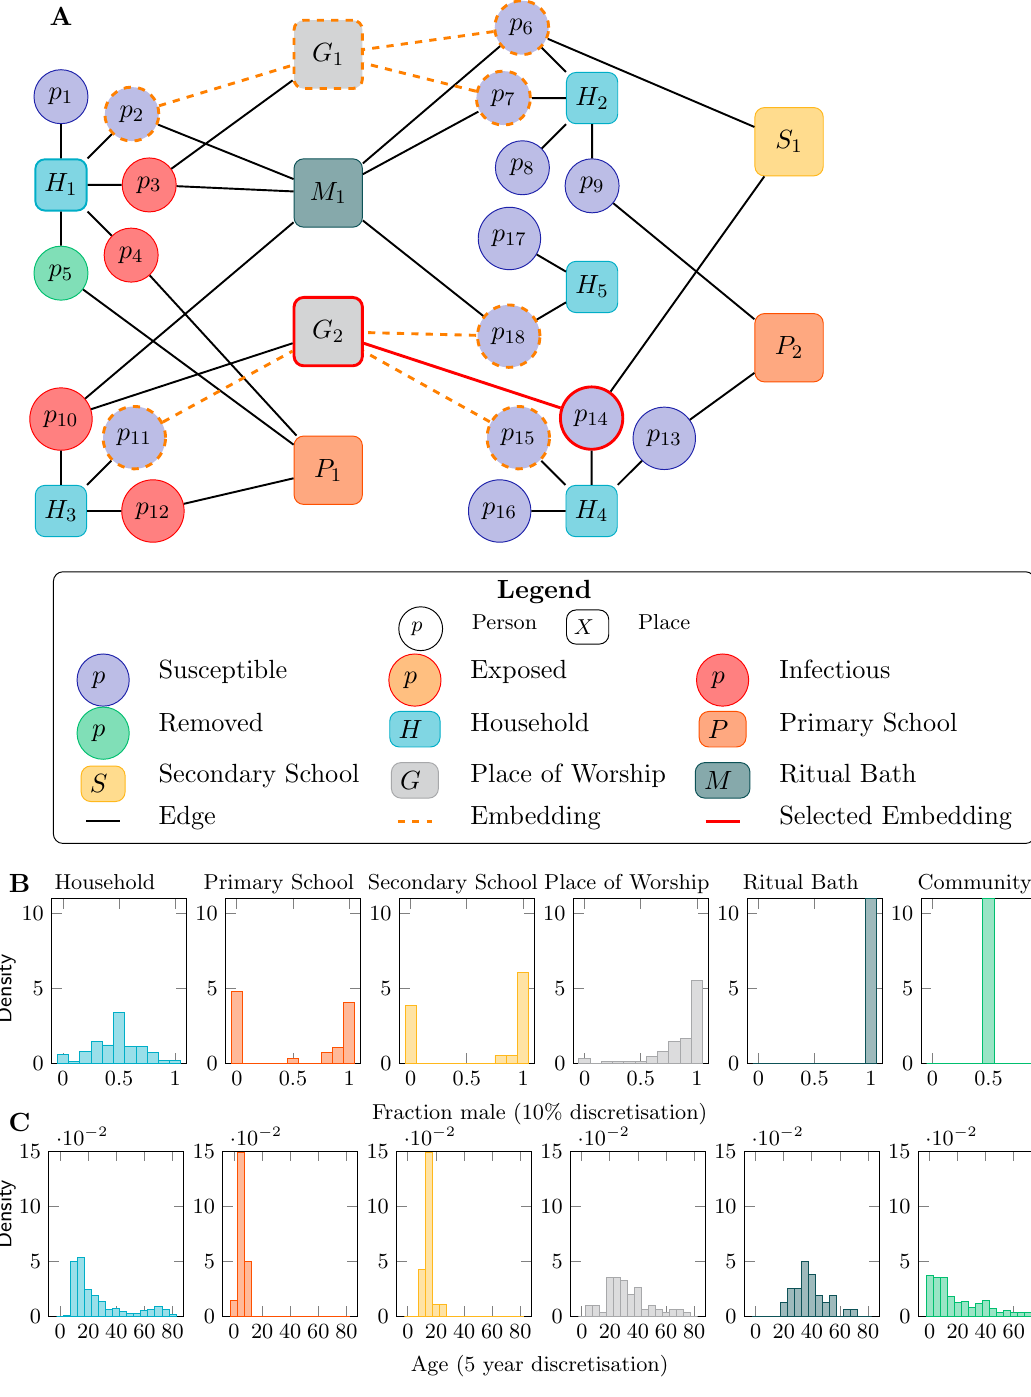
Figure 1. The data and formulation of the people and places network. ( A ) Illustrative representation of a bipartite people and places network. Circles represent people and squares represent places. All people are connected to a household (H). Some people are connected to primary (P) or secondary (S) schools, places of worship (G) or ritual baths (M). The orange dotted, and red solid edges represent embeddings of a transmission rule (Eq. 6) capturing the situation immediately before a transmission event that will result in the individual p14 becoming infected. ( B ) The distribution of the fraction of individuals in each setting who were male. Households were mixed, but the attendees of both primary and secondary schools were strongly bimodal: either predominantly male or predominantly female. Attendance at places of worship and ritual baths was predominantly reported by males. Overall, the community was balanced to within a few percent. ( C ) The distribution of average ages in the various settings (for the community in general, this is simply the age distribution of individuals). Note that attendance at primary school is disjoint with attendance at secondary schools, and attendance at schools was mostly disjoint with places of worship or ritual